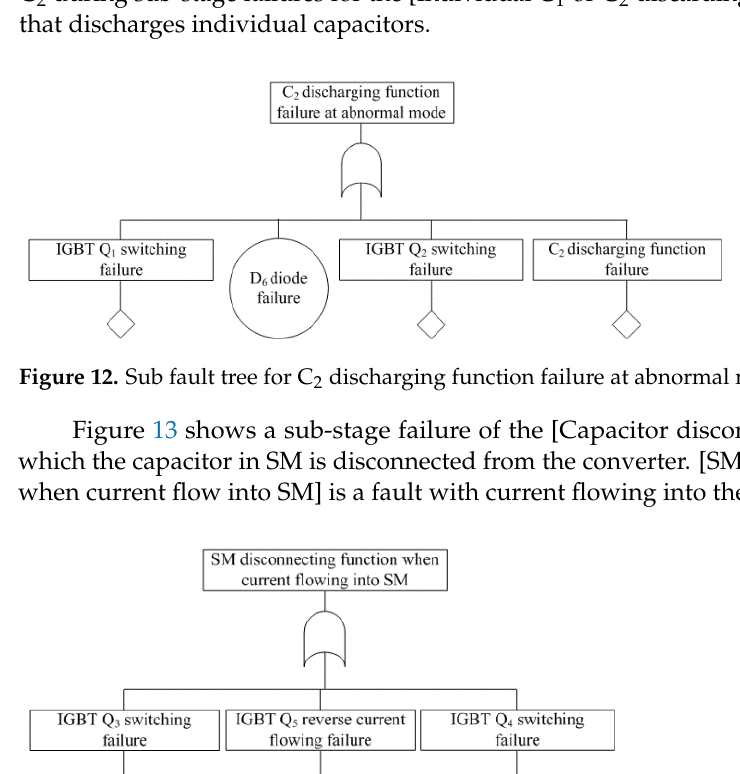
Figure 13. Sub fault tree for SM disconnecting function when current flowing into SM.